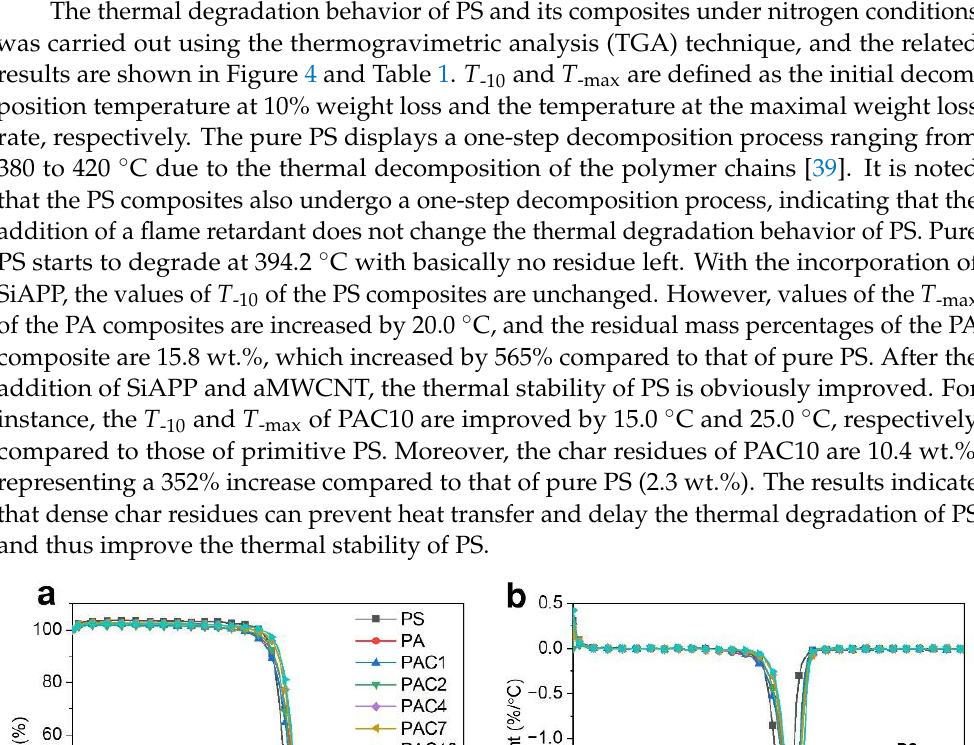
Figure 3. SEM images of fracture surface of ( a ) PS, ( b ) PA, ( c ) PAC1, ( d , e ) PAC2, ( f ) PAC4, ( g , h ) PAC7, and ( i ) PAC10 after hot-pressing.